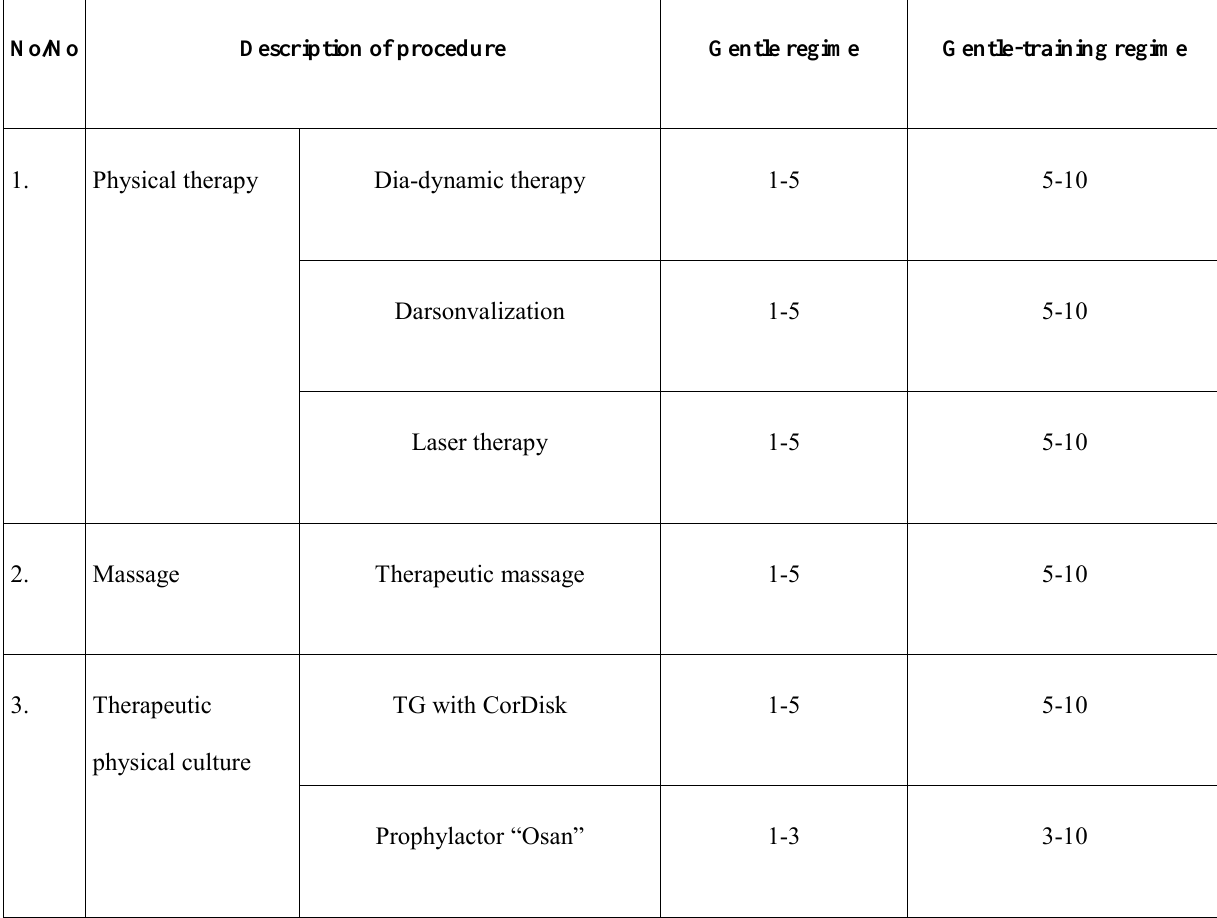
List of procedures by motion regimes of sportsmen with ostheochodrosis in period of medical rehabilitation